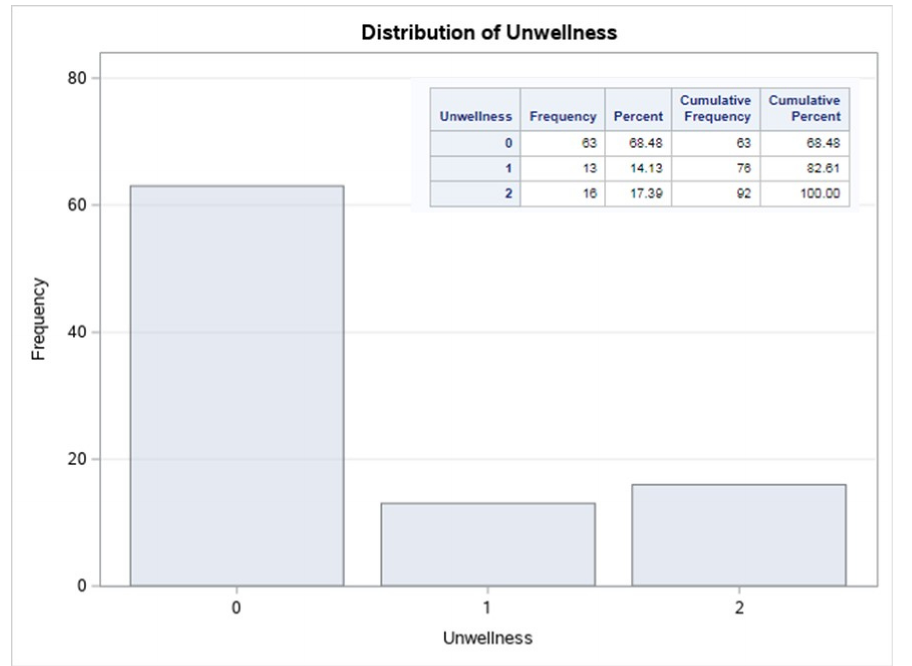
Figure 8. Distribution of well-being.